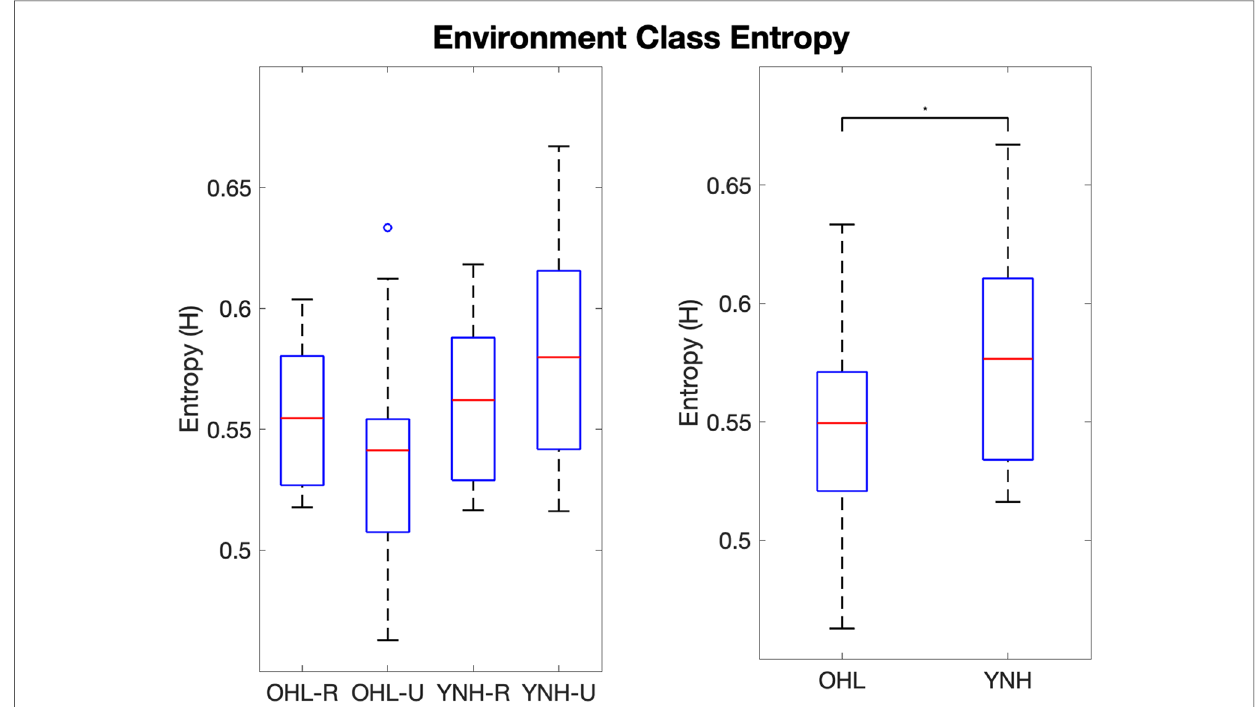
FIGURE 3 Boxplots of environment class entropy values per group (left) and groups combined along age and hearing status (right). OHL-R, older hearing loss rural; OHL-U, older hearing loss urban; YNH-R, younger normal hearing rural; YNH-U, younger normal hearing urban. OHL, older hearing loss (rural and urban combined); YNH, younger normal hearing (rural and urban combined). Vertical bars represent values within the fi rst and third quartiles þ = (cid:2) the interquartile range (cid:3) 1.5. Dots represent outliers. * indicates p , 0 :